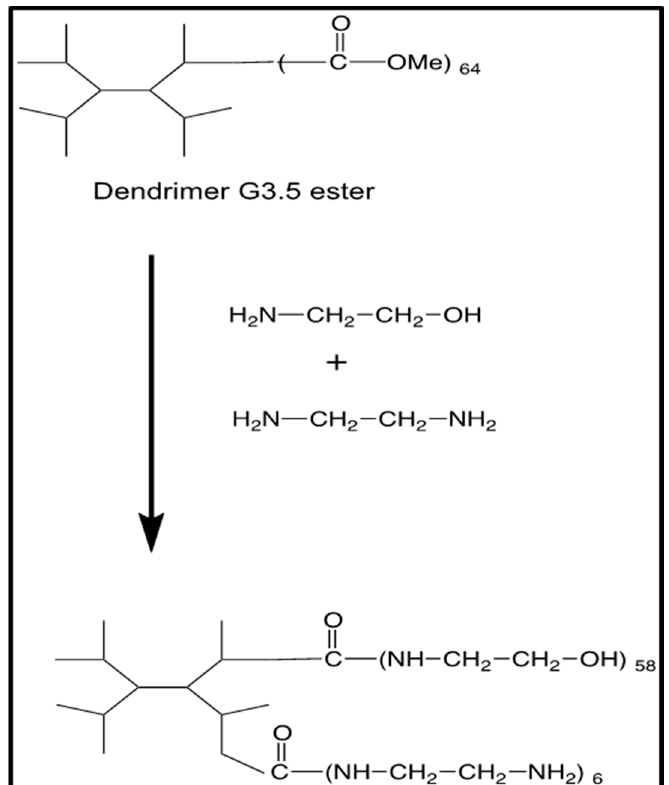
Figure 2. Synthesis of G4-90/10.